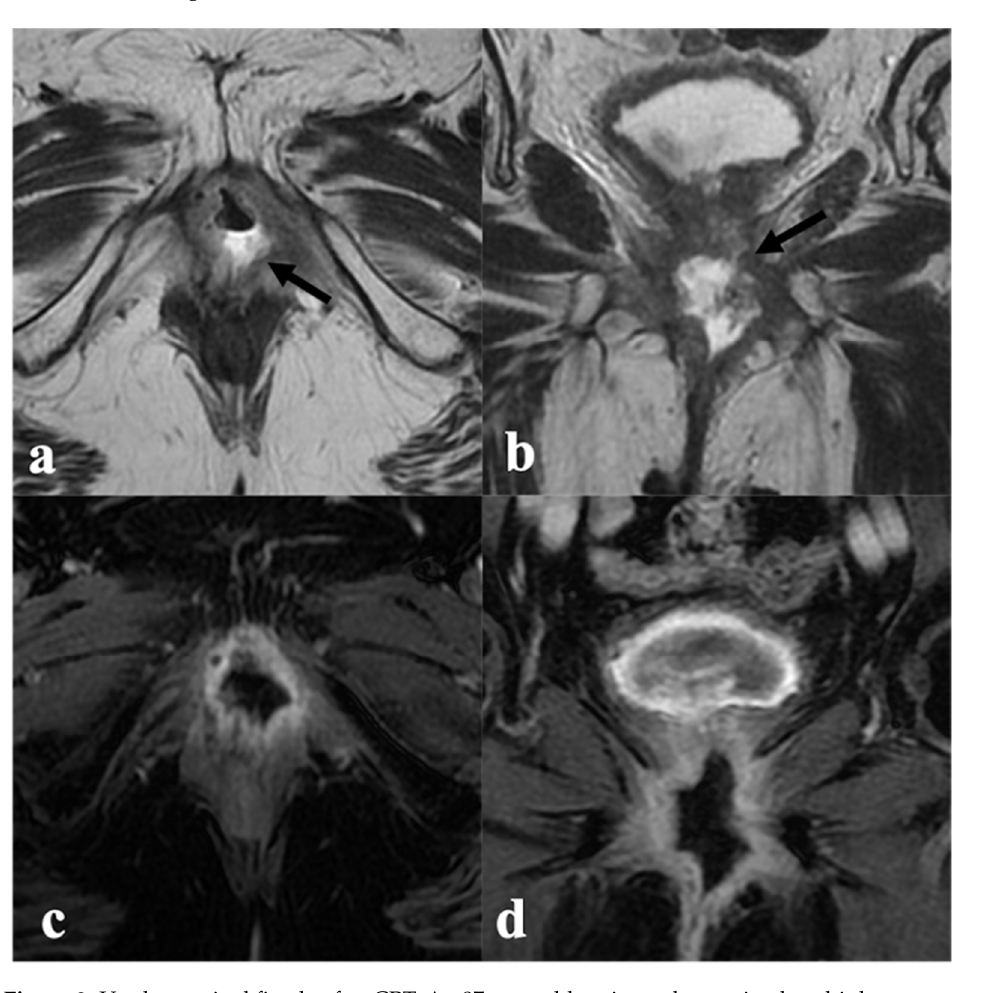
Figure 10. Anovaginal fistula after CRT. A 58-year-old patient treated with CRT for locally advanced vulvar cancer (FIGO stage IVA), presenting with a fluid-filled anovaginal fistulous tract connecting the lower vagina and the anal canal (( a , b )—white arrow), with marked peripheral enhancement in post-contrast T1-WI ( c ).